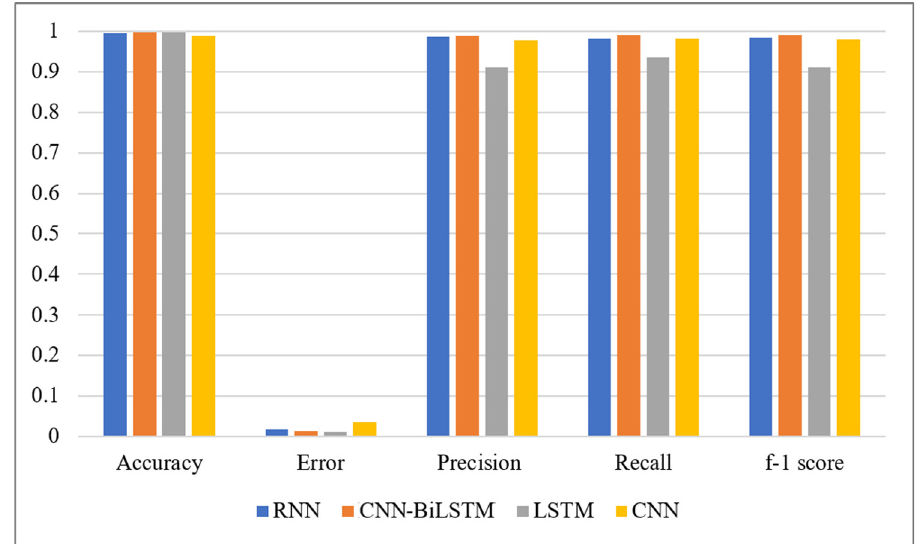
Figure 9: The comparison between the four classi fi cation models.